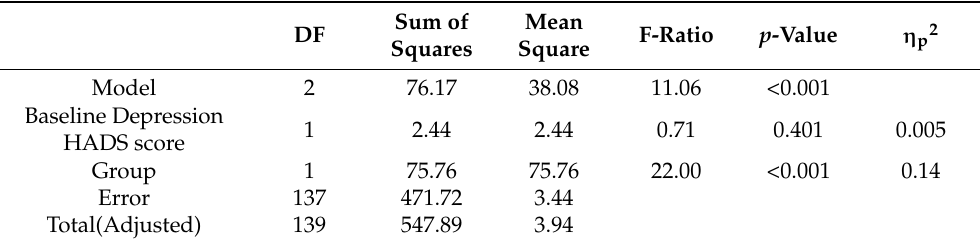
Table 4. Effect of group on change of MMSE total score after adjustment on background HADS depression subscale score.